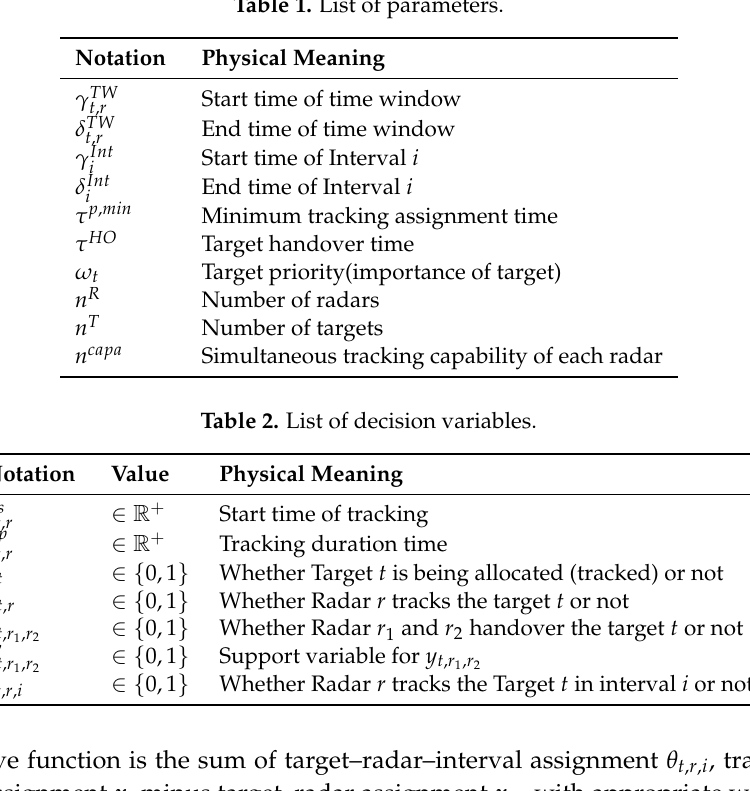
Table 1. List of parameters.